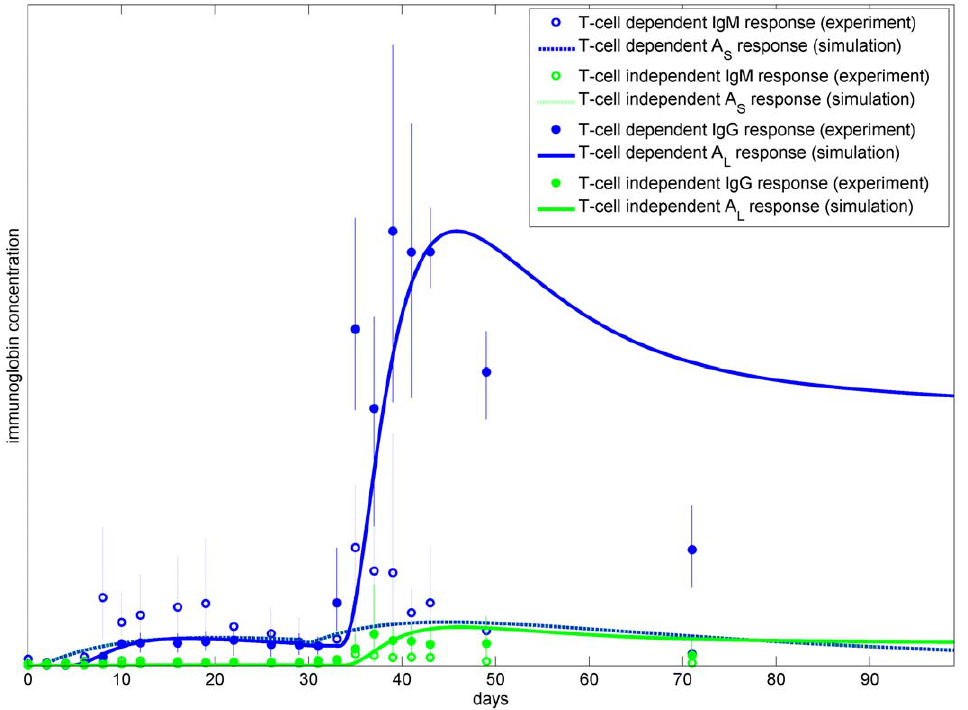
Figure 8. Experimental and simulation results for IgM ( A S ) and IgG ( A L ) for the full system (blue) and for the system with a reduced T-cell dependent response only (green). Here the mean and range of each of the datasets from Figure 6 are plotted, together with the simulation results from Figure 7, with the model outputs suitably scaled (the peak of the experimental mean for each of the two immunoglobulins matched by the peak of the full T-dependent system).